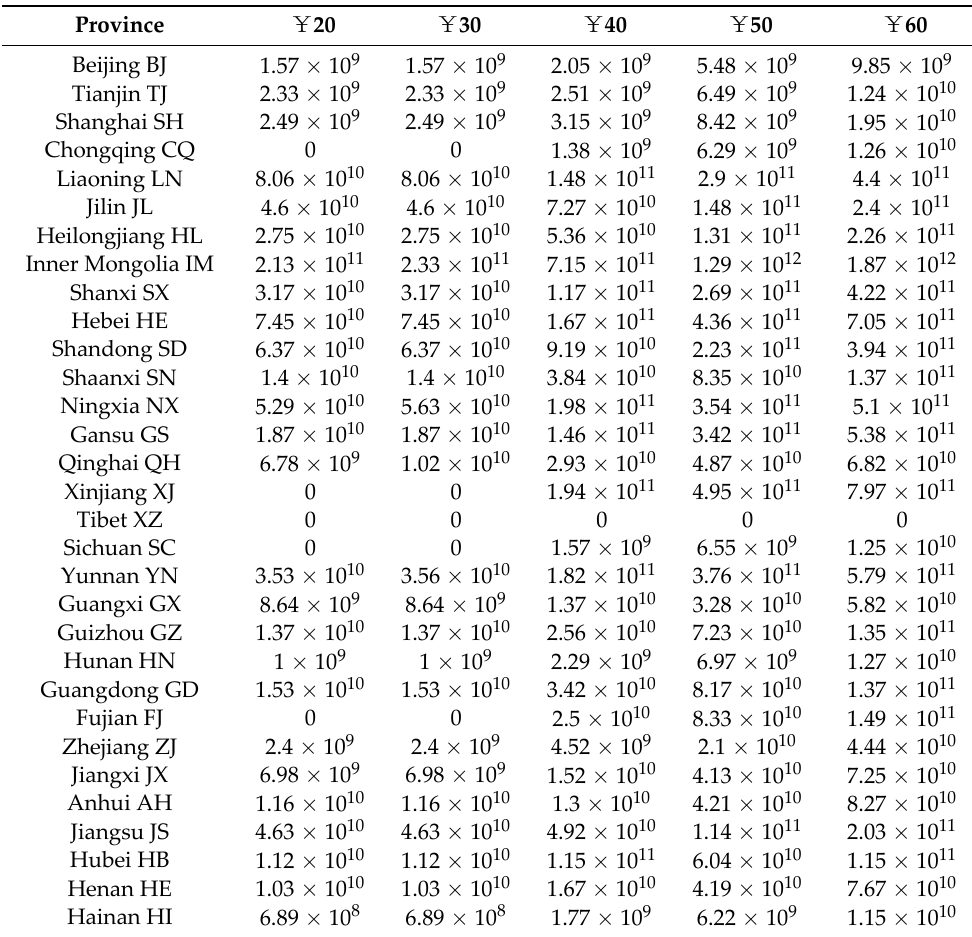
Table A3. NPV results.